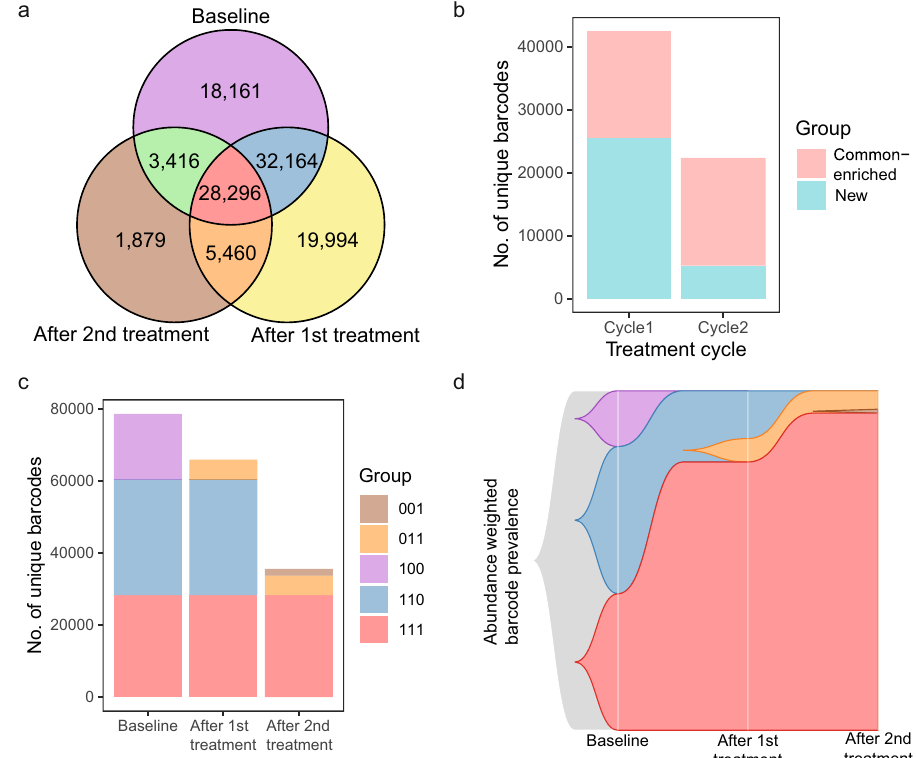
Fig. 5 Navitoclax treatment selects pre-existing resistant clones. a The number of common unique barcodes between baseline, post- treatment cycle 1, and post-treatment cycle 2 samples. b The number of new and existing clones that increased in abundance as detected at end of each cycle: Cycle 1 — Post 1st treatment versus Baseline; Cycle 2 — Post 2nd treatment versus Post 1st treatment. c The distribution of barcodes divided into the 5 subgroups de fi ned in panel a , shows a considerable decrease in barcode complexity after treatment. Groups are labeled by a sequence of three numbers representing inclusion (1) or exclusion (0) in the baseline, post-cycle 1, and post-cycle 2 samples. d Clonal evolution of cancer cells estimated by the observed barcode prevalence weighted by the abundance of each